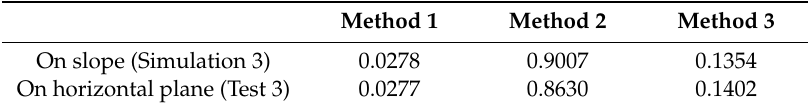
Table 7. Average values of stability evaluations when the robot trotting on the 12 ◦ slope and horizontal plane.